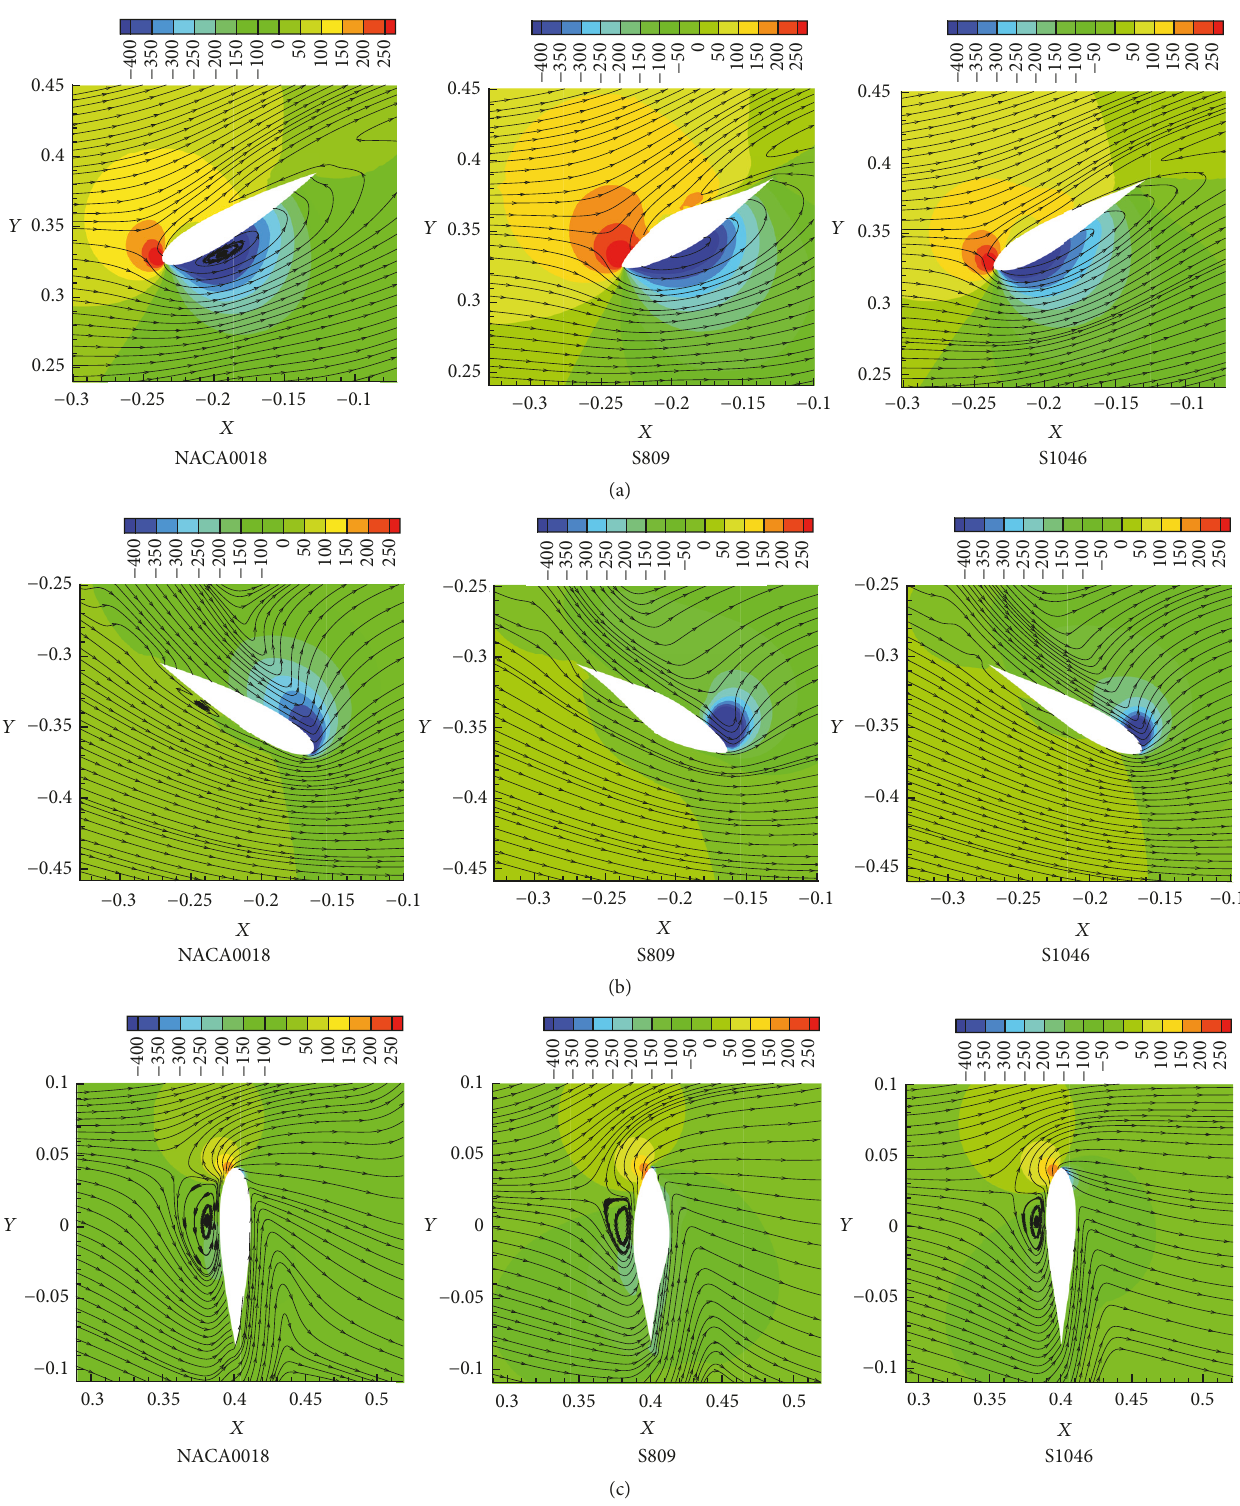
Figure 11: Flow fields around blade with different airfoils ( 𝜃 = 35 ∘